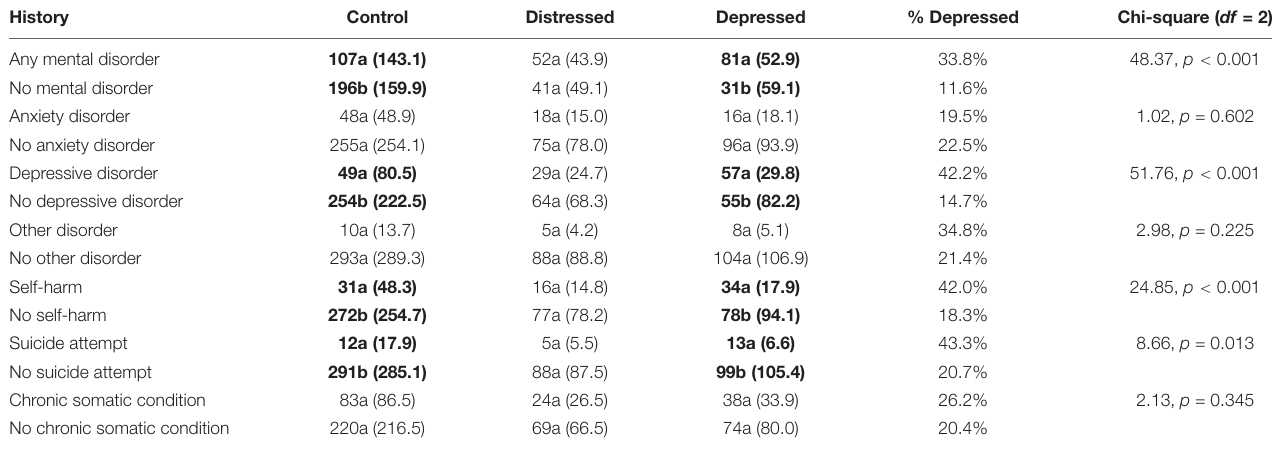
TABLE 5 | The relationship between depression and previous history of psychiatric and/or chronic somatic disorders (Chi-square